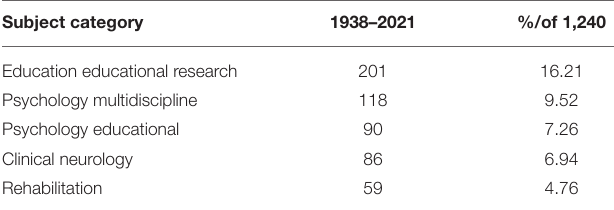
TABLE 1 | Top 5 subject categories based on